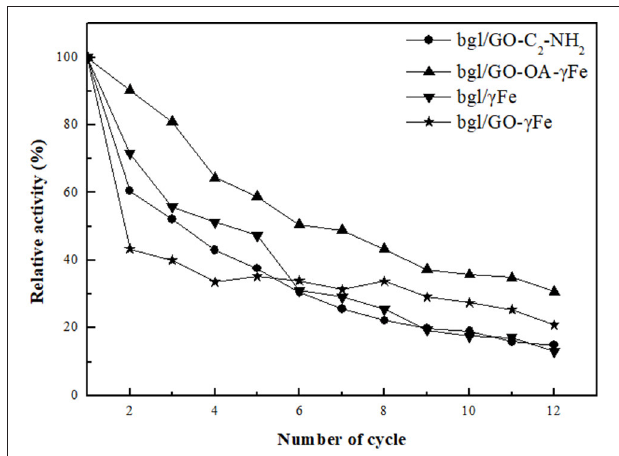
FIGURE 8 | Reusability of immobilized bgl for the hydrolysis of p